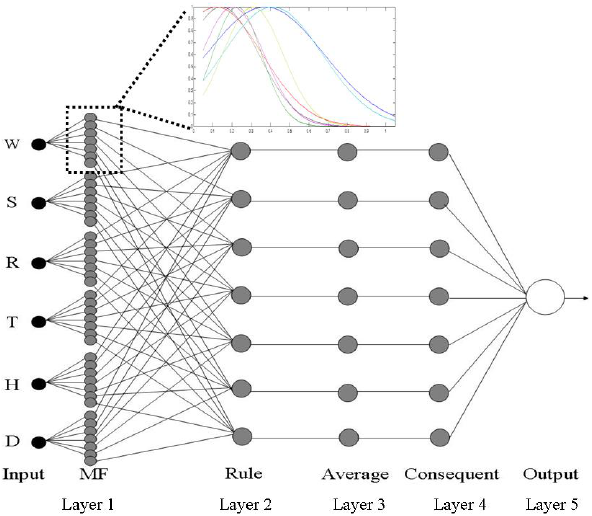
Fig. 1. Architecture of an ANFIS model with seven fuzzy rules for evaporation estimation. W, S, R, T, H and D are wind speed, sunshine hour, radiation, temperature, humidity and dew point temperature, respectively. Fig. 2. Flowchart of the constructed AK model for estimating the spatial distribution of evaporation.